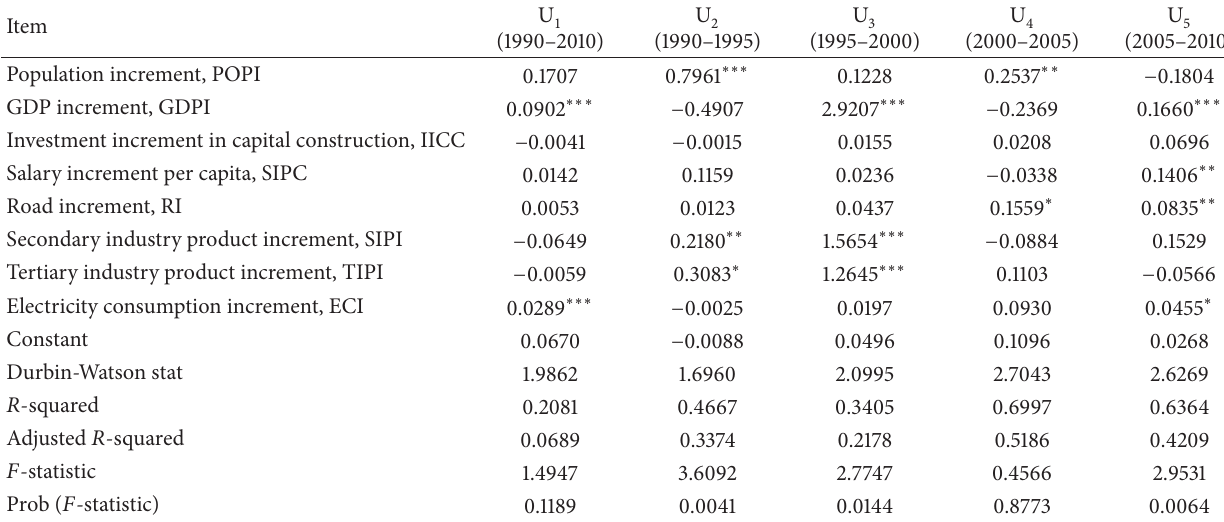
Table 6: Urban expansion and driving factors in Western